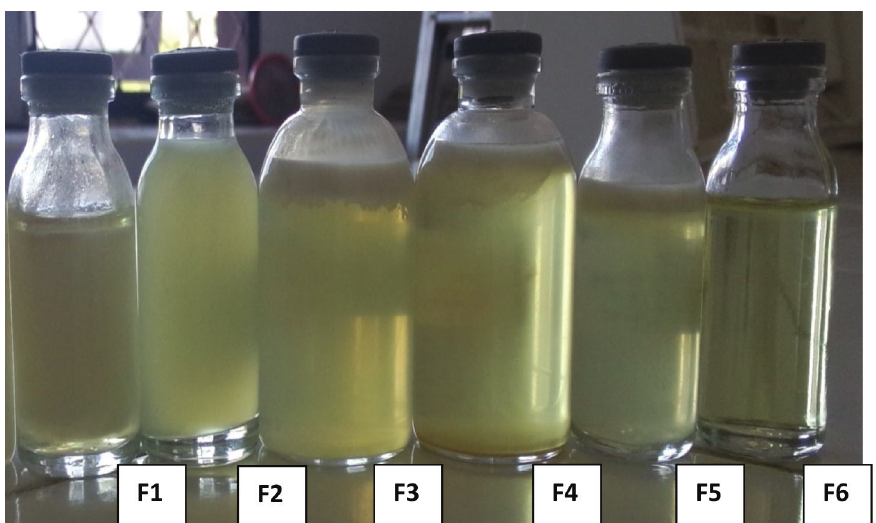
FIGURE 1 - The optimization result of nanoemulsion basis based on the solubility of snakehead fish powder among surfactant, co-surfactant, and oil. TABLE III - Effect of low-pressure homogenization process variables on mean Droplet Size (DS) and Polydispersity Index (PDI) of various nanoemulsion formulations